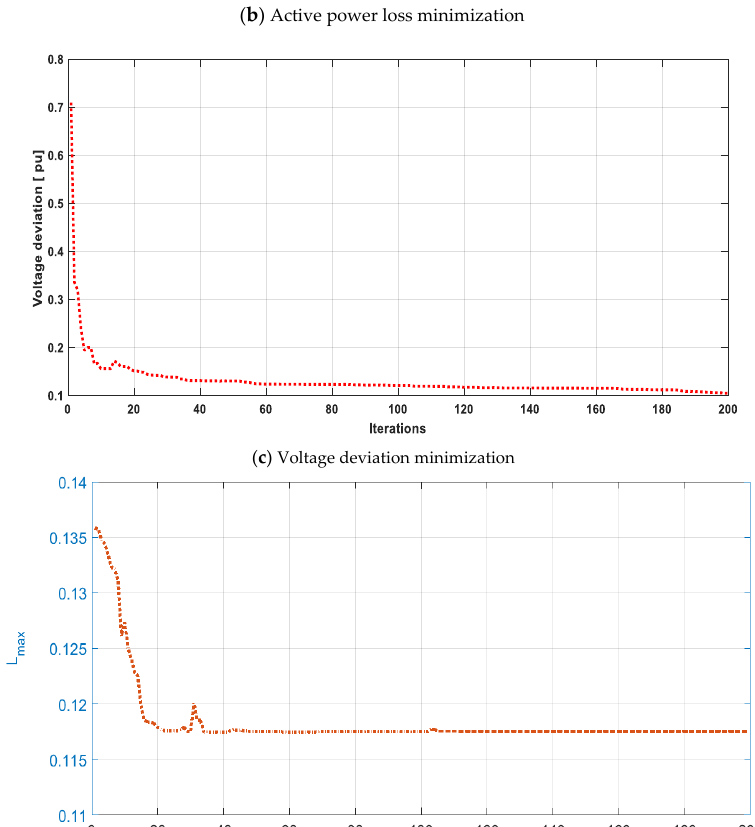
Figure 5. Convergence characteristic curves for the SOF-OPF